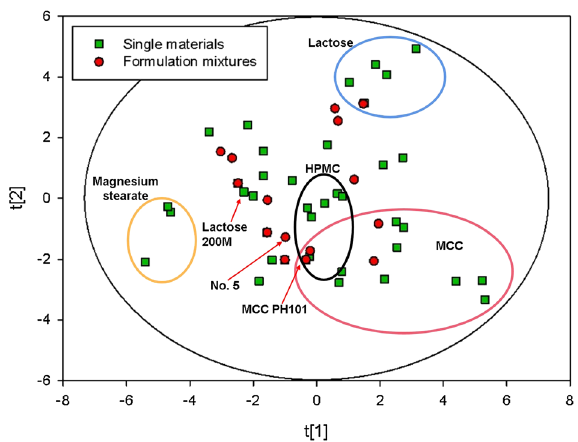
Figure 3. The PC1 vs PC2 score scatter plot. The color of the dots indicates different data sets where the green and red represent single materials and formulation mixtures respectively. The shape varies to discriminate where the data comes from: square means data extracted from iTCM database, circle represent data collected from literature